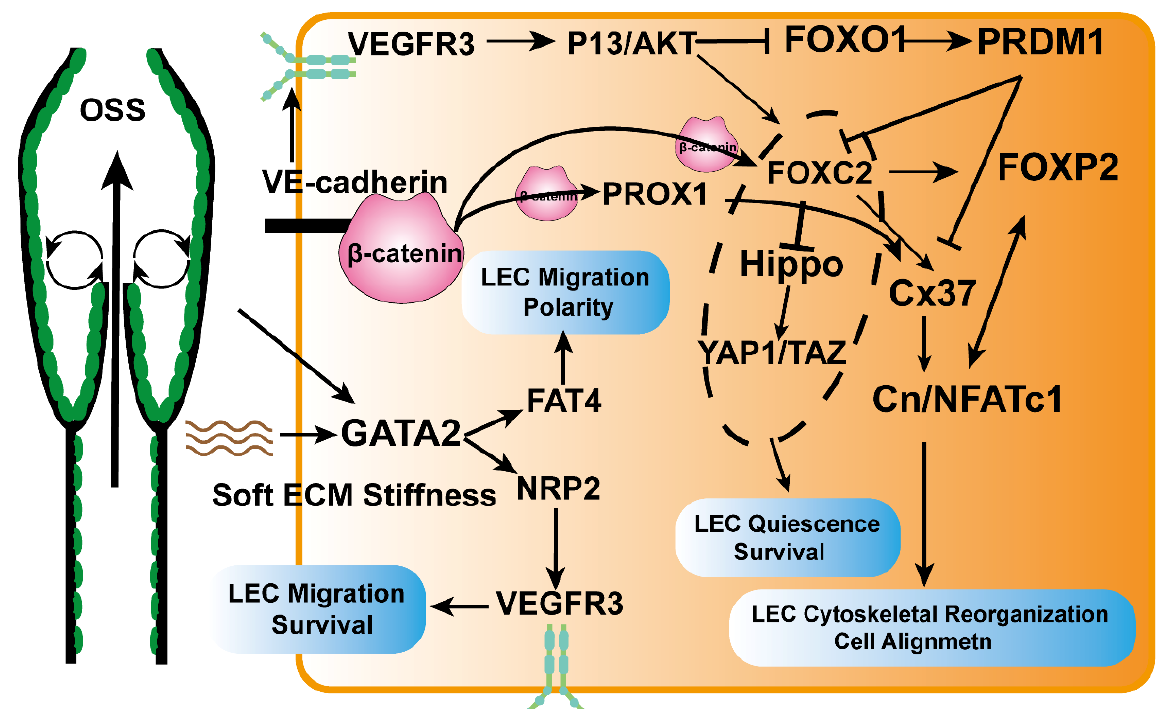
Figure 3. Molecular mechanism of the effect of mechanical signals on LECs. Transcription factors GATA2, FOXC2, and FOXO1 are important target molecules in LECs regulated by mechanical signaling. In response to OSS signaling, VE-cadherin can bind to β -catenin to drive FOXC2 and PROX1 transcription and can phosphorylate VEGFR3 to activate the P13/AKT pathway. AKT phosphorylation can inhibit the transcription of FOXO1 and induce the expression of FOXC2. FOXO1 inhibits the activity of FOXC2 and Cx37 by regulating PRDM1 and inhibits valvular lymphatic production. FOXC2 inhibits the Hippo pathway and downstream YAP1/TAZ to aid in the quiescence and survival of LECs. In addition, FOXC2 cooperates with PROX1 and FOXP2 to regulate Cx37 and Cn/NFATc1 to control LEC cytoskeleton remodeling and cell alignment in response to OSS. OSS and soft ECM stiffness can activate transcription of GATA2. GATA2 mediates LEC migration and polarity via FAT4 on the one hand and migration and survival via NRP2/VEGFR3 on the other. FOXO1 is a negative regulator of vascular development [71]. The phosphorylation of AKT induced by sensing the bidirectional flow shear force can inactivate FOXO1, down- regulate the transcription factor PRDM1, relieve the transcriptional inhibition of Cx37 and FOXC2, and induce valvular formation